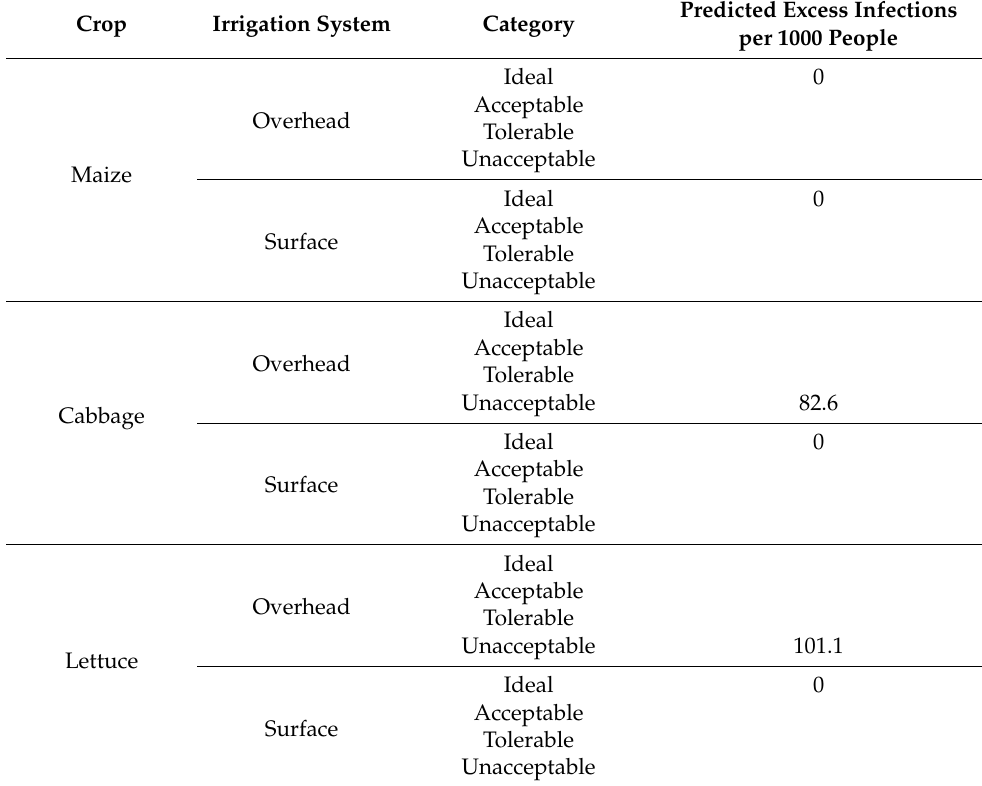
Table 9. The fitness for use of AF effluent with focus on predicted excess infections per 1000 people per annum depending on crop type and irrigation